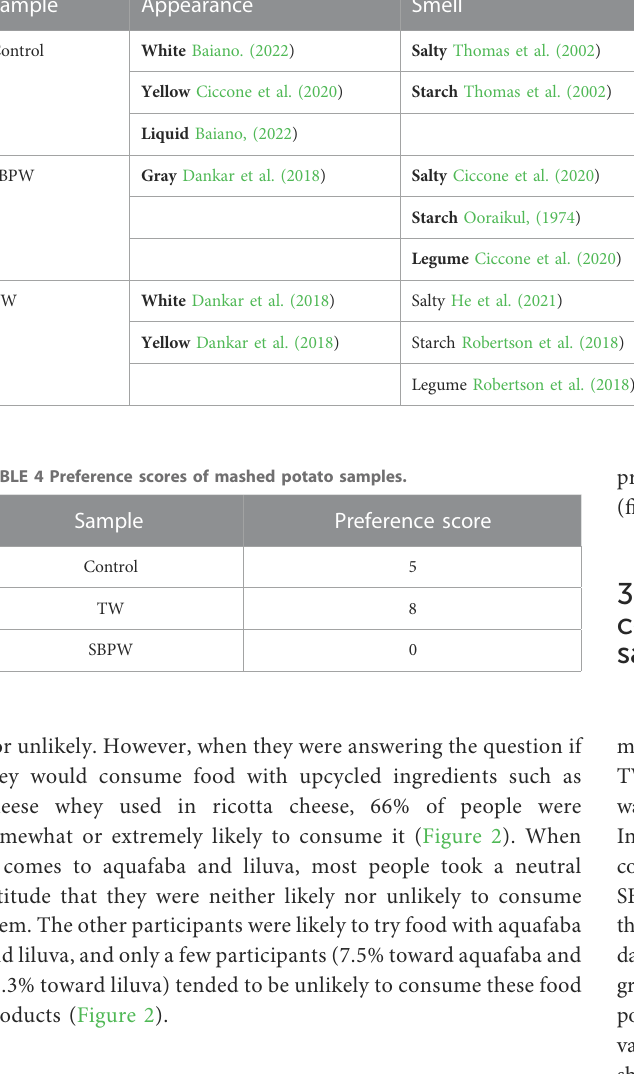
TABLE 3 Sensory descriptive word results from focus group panelists regarding 3D-printed products. Numbers in the brackets are the vote values each word received. Descriptors agreed by at least 5 panelists are bold. Sample